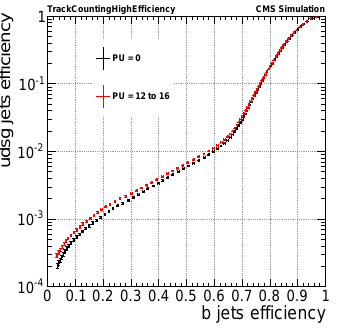
Fig. 6. Light flavor mistag e ffi ciency versus b-tagging e ffi ciency for di ff erent pileup scenario, for the TCHE